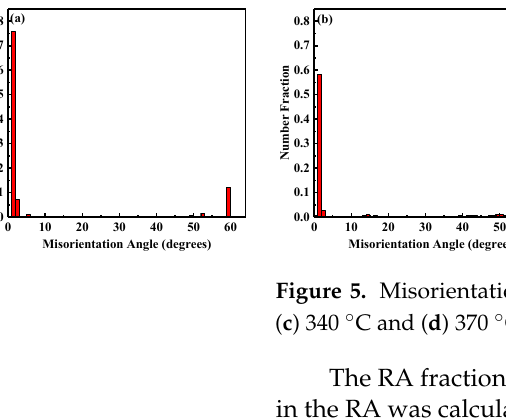
Figure 4. The statistical partitioning of residual austenite grain size in samples: ( a ) 280 ◦ C, ( b ) 310 ◦ C, ( c ) 340 ◦ C and ( d ) 370 ◦ C.